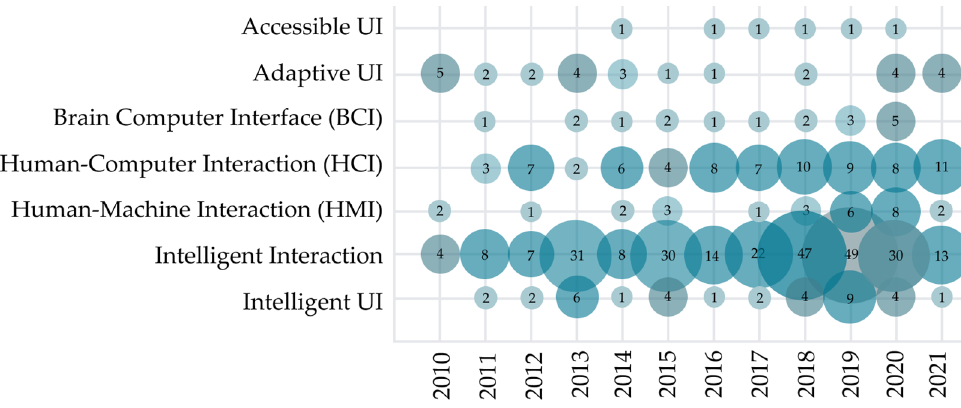
Figure 11. Number of studies by year and research standpoint.